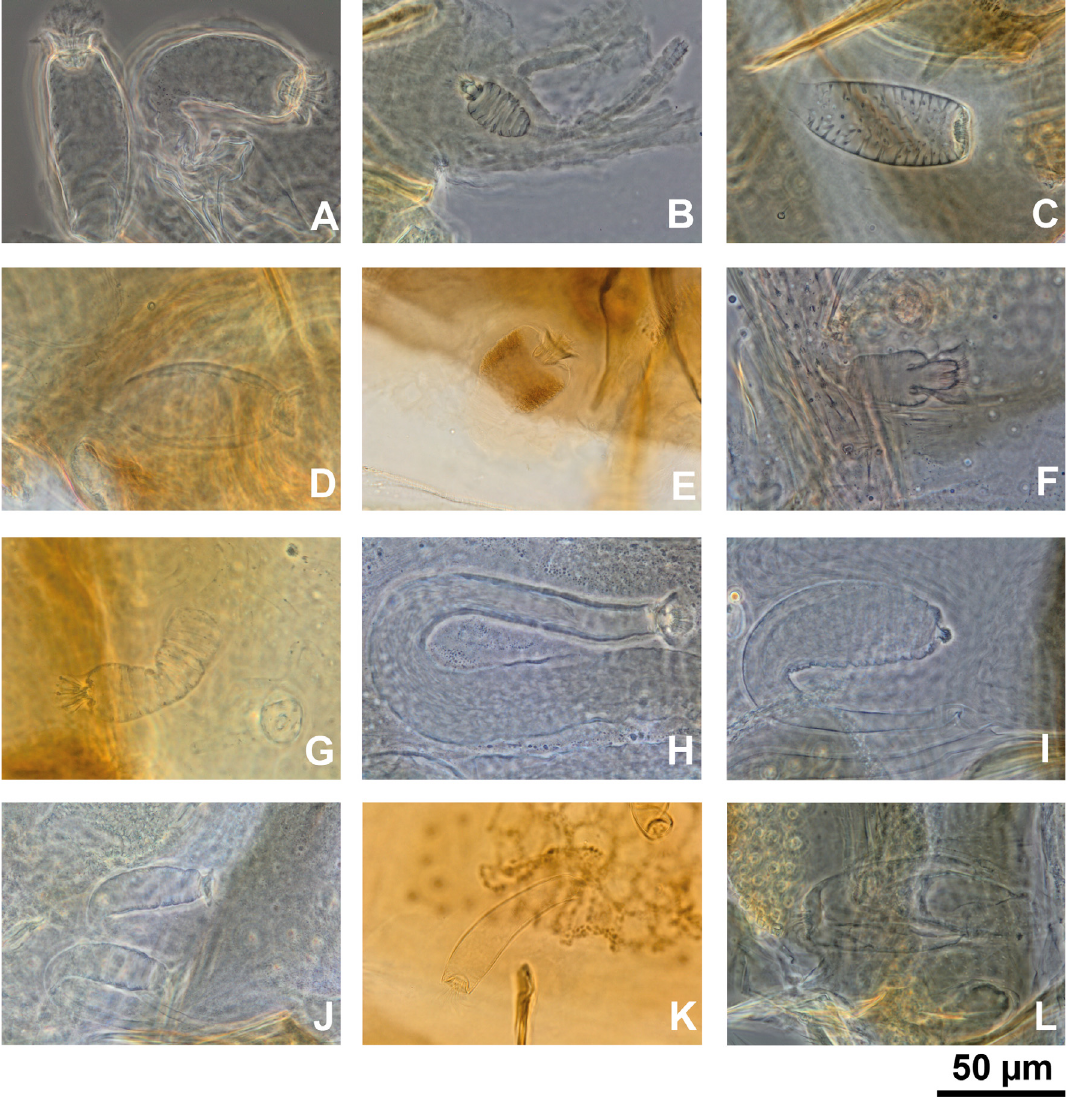
Figure 1. Spermathecae of Sergentomyia spp. s. l.: Sergentomyia ( Sergentomyia ) minuta (A); Sergentomyia ( Sintonius ) clydei (B); Sergentomyia ( Rondanomyia ) goodmani (C); Sergentomyia ( Parrotomyia ) magna (D); Grassomyia sp. from Madagascar (E); Sergentomyia ( Vattieromyia ) anka (F); Demeillonius transvaalensis (G), and the following ungrouped species: Sergentomyia anodontis (H); Sergentomyia quatei (I); Sergentomyi asylvatica (J); Sergentomyia majungaensis (K); and Sergentomyia bailyi